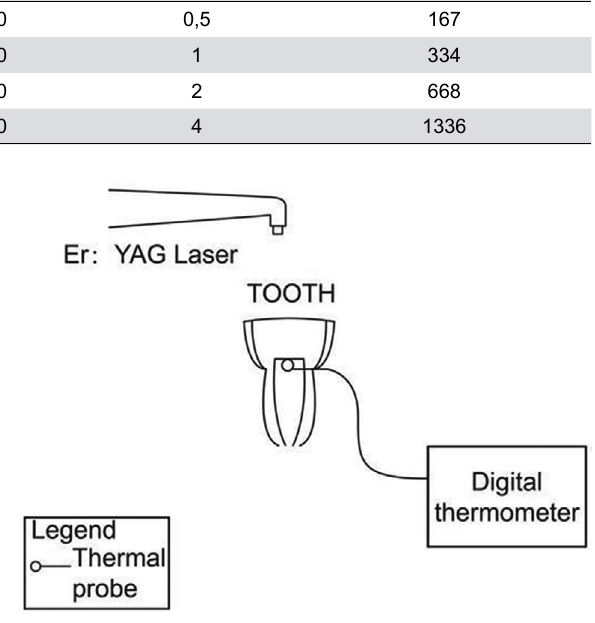
Figure 2- Schematic diagram of detection of temperature changes in pulp